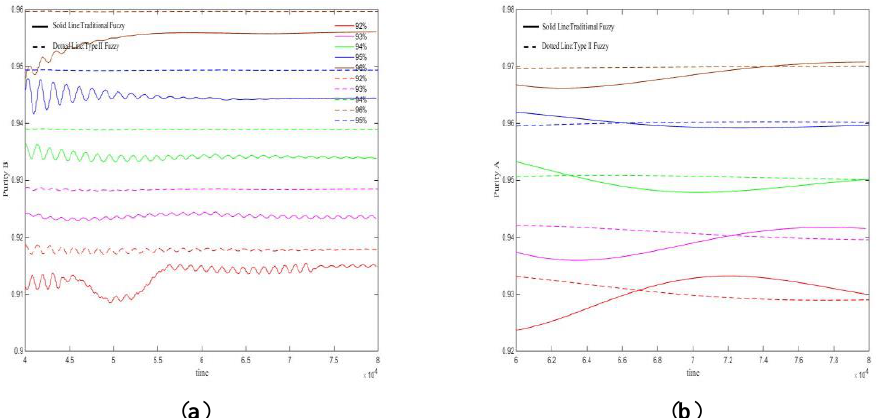
Figure 14. Under the change of the adsorbent parameter . ( a ) Extraction outlet (material B); ( b ) raffinate outlet (material A).